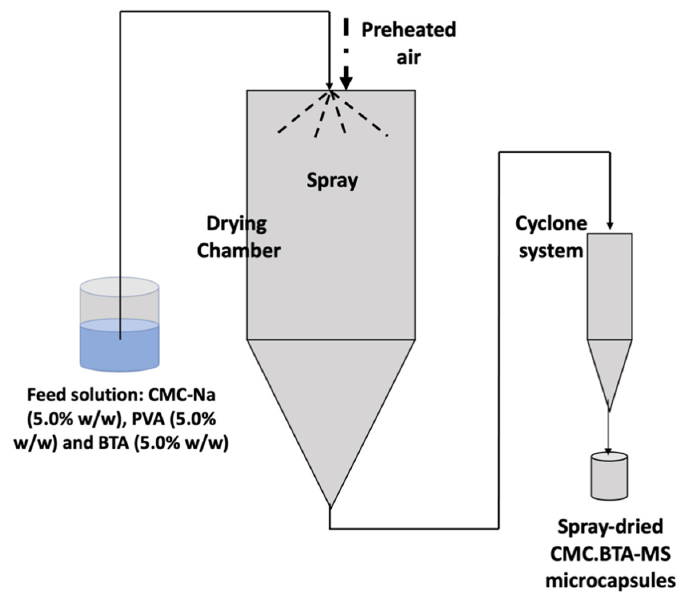
Figure 1. SchematicillustrationofthepreparationofCMC.BTAmicrospheresbyaspraydrying Figure 1. Schematic illustration of the preparation of CMC.BTA microspheres by a spray drying procedure . Table 1. Experimental conditions for the preparation of CMC.BTA ‐ MS by spray drying.